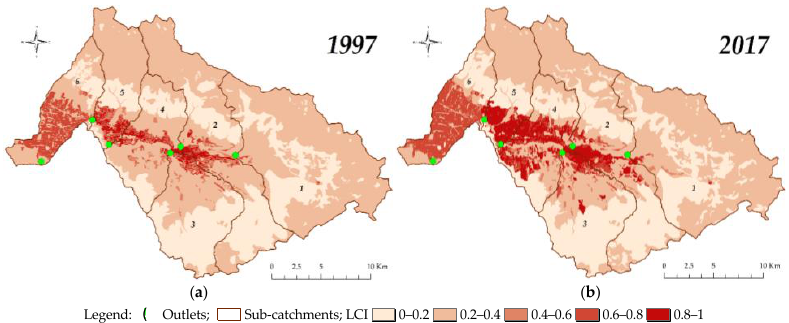
Figure 7. Land cover indicator (LCI) values for sub-catchments 1–6 in ( a ) 1997 and ( b ) 2017.